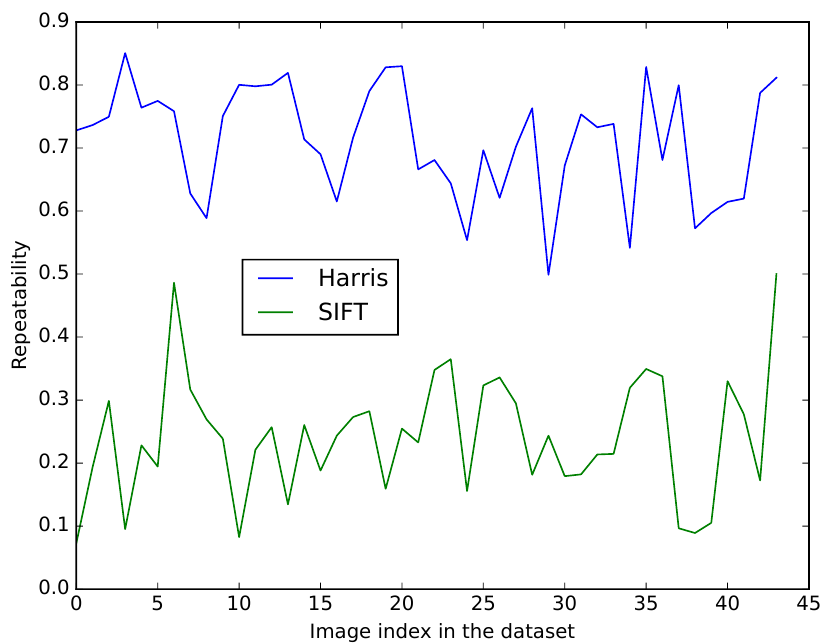
Figure 7. Detectors repeatability on LWIR dataset according to each image pair in the